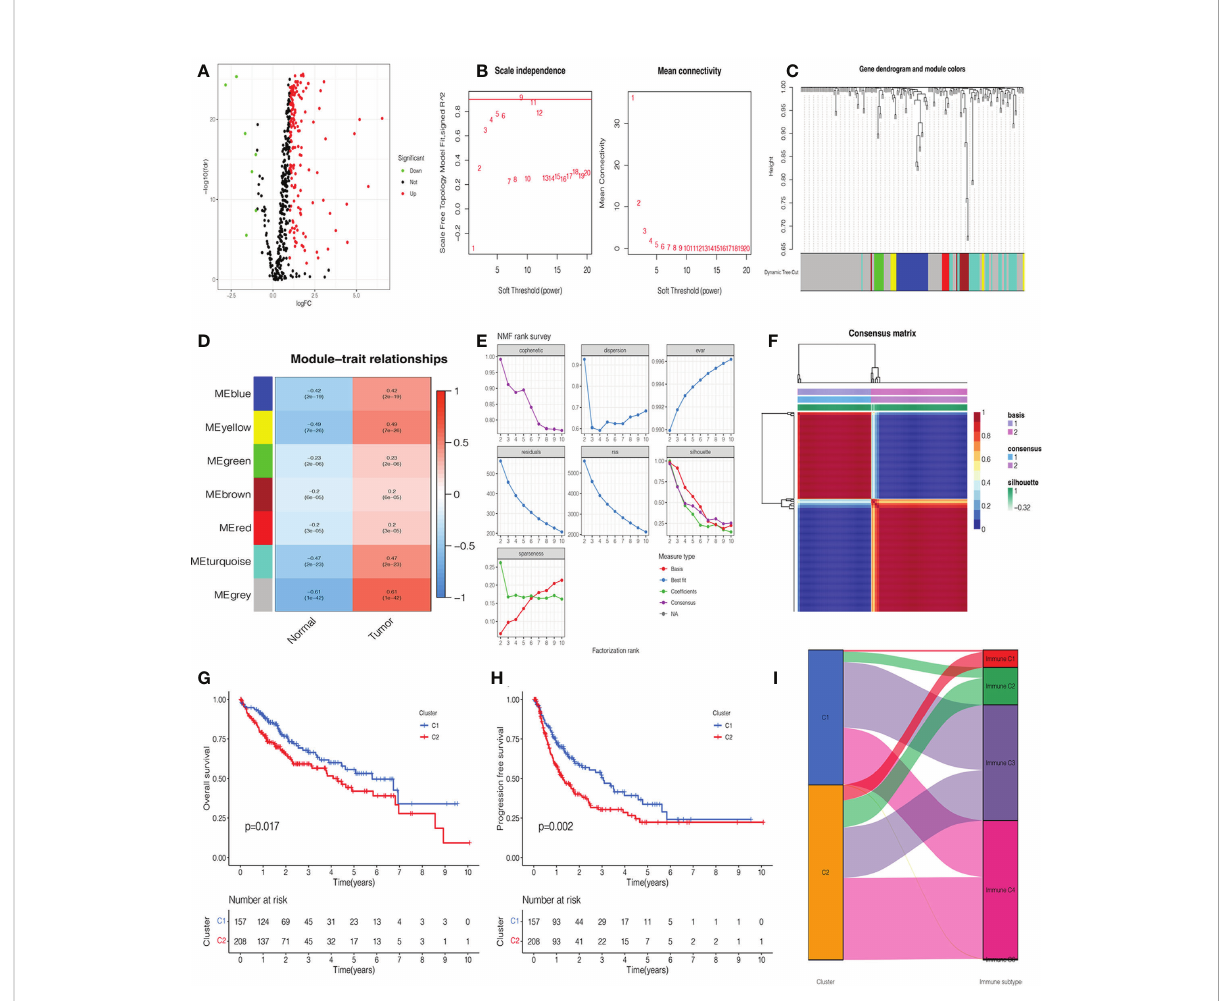
FIGURE 2 Identi fi cation of glycosylation-related differentially expressed genes (DEGs), functional modules, and molecular subtypes. (A) Volcano plot of 201 glycosylation-related DEGs in hepatocellular carcinoma (HCC). (B) The distribution of the scale-free topology model fi t and the trends of mean connectivity. (C) The hierarchical clustering analysis presented similar characteristics with the same color by a dendrogram. (D) The correlation between the trait and each module in HCC and normal tissues. (E) Non-negative matrix factorization (NMF) survey analyzed the factorization rank, including cophenetic, dispersion, evar, residuals, rss, silhouette, and sparseness coef fi cients. (F) Heatmap of two clusters of HCC. Kaplan – Meier (K-M) curves of overall survival (OS) (G) and progression-free survival (PFS) (H) in two clusters of patients with HCC. (I) The association between clusters and immune C1, C2, C3, and